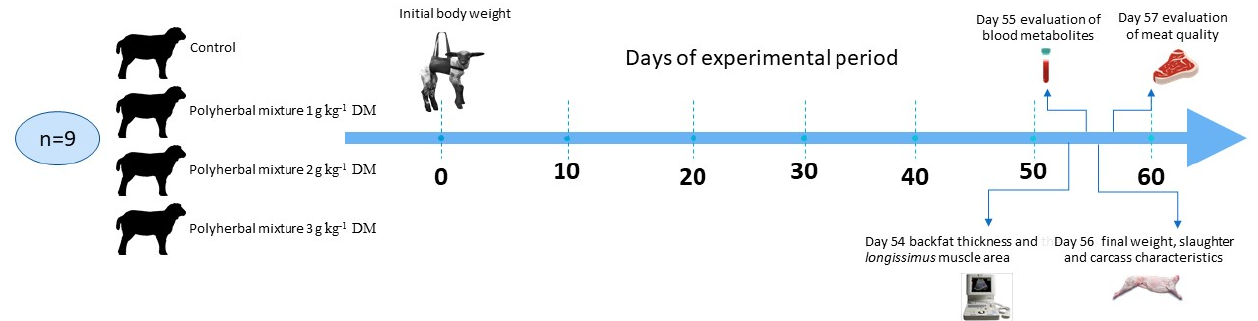
Figure 1. Completely randomized design and sampling times of lambs supplemented with a polyherbal mixture during the final fattening period; n = 9 indicate the number of animals sampled in each treatment; DM = dry matter.